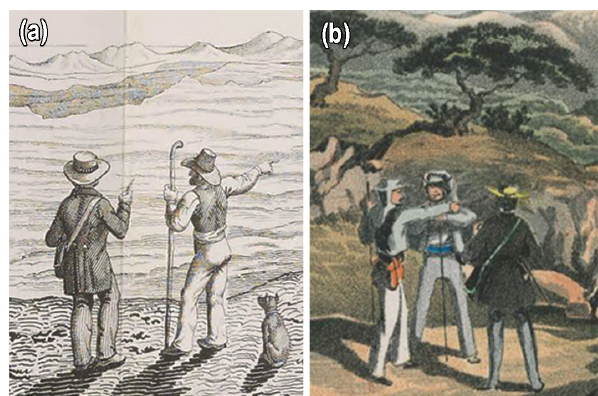
Figure 1. Details of two illustrations depicting Georg Hartung per- forming fieldwork. (a) Hartung (left figure with a hat) taking notes from his guide on Fuerteventura, Canary Islands (extracted from plate III in Hartung, 1857b; https://www.biodiversitylibrary.org/ item/46730#page/320/mode/1up, last access: 26 September 2021). (b) The same person on São Miguel Island (Azores archipelago) talking with the locals (extracted from plate VII in Hartung, 1860a; https://www.e-rara.ch/zut/content/zoom/7111419, last ac- cess: 26 September 2021). Both images are public domain.